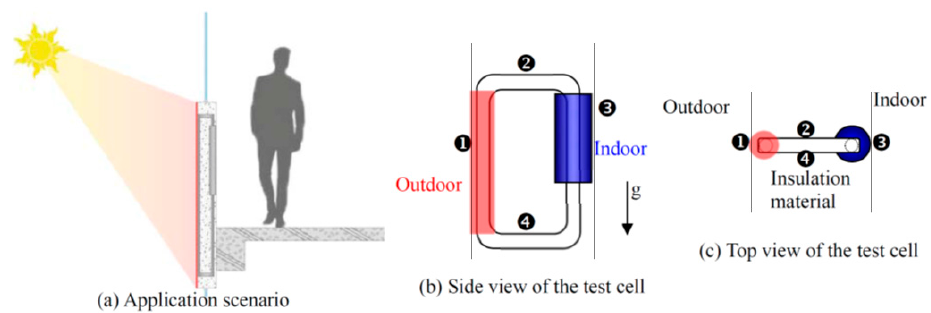
Figure 1. Scenario and test cell illustration.